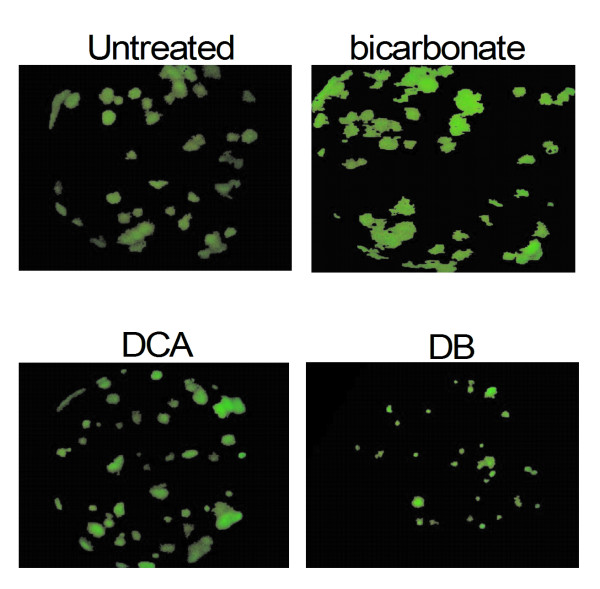
Representative pulmonary lesions from the four study cohorts. Green fluorescent lung tumor metastases from necropsies were detected by the Illumatool Bright Light System (LT-9500) using a 470 nm/40 nm excitation filter (Lightools Research). Whole lung images were captured in the frame of view at the same focal plane in the presence of 480-nm excitation and > 490-nm filtered emission.